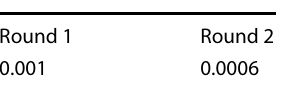
Table 2 Entropy measurement results.